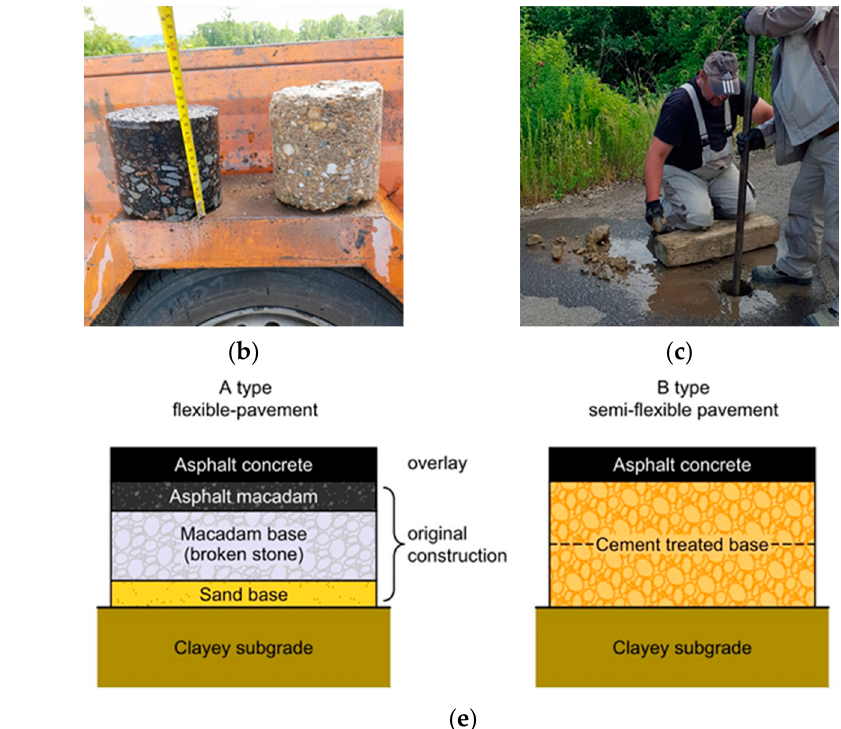
Figure 15. GPR equipment used in this project (source: RODEN Engineering Office).